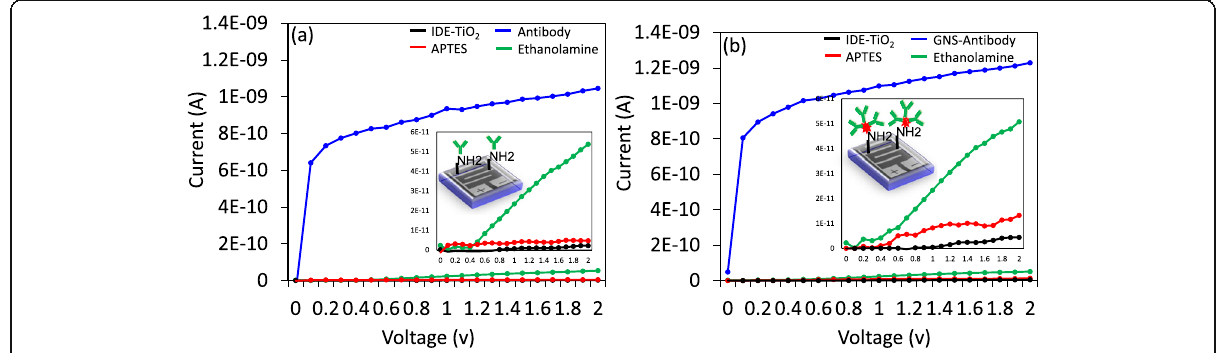
Fig. 3 Immobilization processes on IDE-TiO 2 surfaces. a With antibody. b With GNS antibody. Surface modifications were started by 3% APTES, followed by EDC and NHS activation to immobilize the antibody; 1 M of ethanolamine was used to block the unattached antibody region. A linear sweep voltage of 0 to 2 V at 0.01 V step voltage was followed for the measurements. Proper changes in current after each